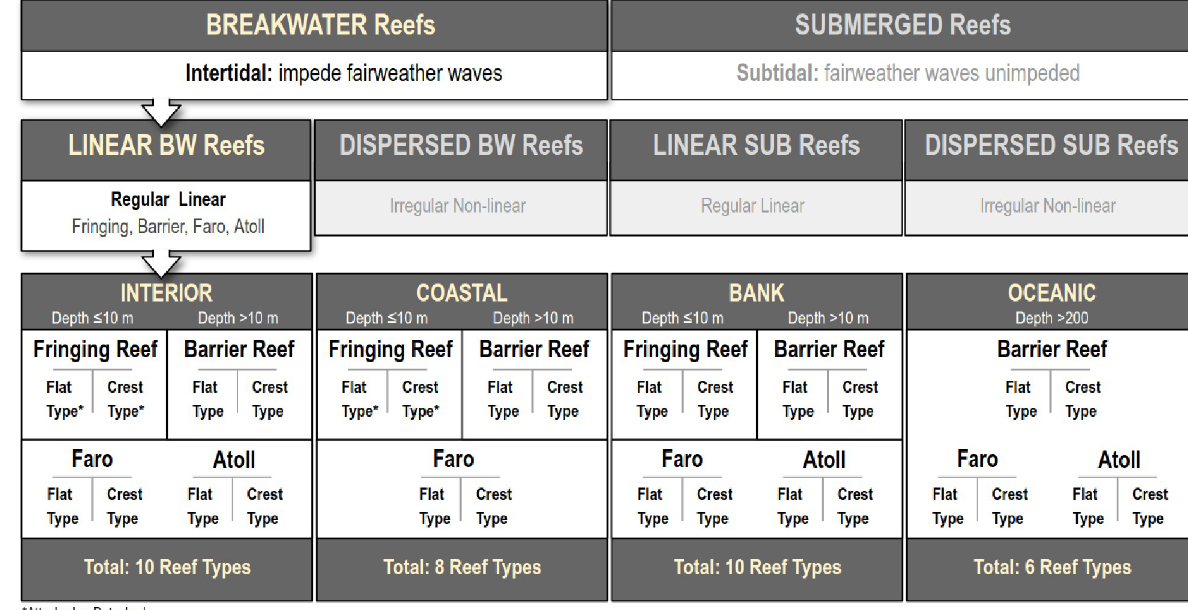
Fig 1. Standardised geomorphic classification of coral reefs showing the subcategories of linear breakwater reefs. There are 4 levels: The first is based on depth, with two categories, intertidal breakwater reefs, and subtidal submerged reefs. The second is based on form, with two categories, linear BW reefs and non-linear or dispersed BW reefs. The third, for linear BW reefs, is based on physiographic setting with four categories, Interior (protected Lagoons and Bays), Coastal (continental or insular shelves � 5 km wide), Bank (waters with a shelving seafloor shallower than 200 m, including shelves > 5 km wide) and Oceanic (waters lacking a shelving seafloor shallower than 200 m). The fourth is based on shallow geomorphology with two categories, Crest-type (sloping to subtidal depths on either side of the crest) and Flat-type (with an intertidal platform behind the crest). A final modification term for Fringing reefs is Attached to the coast (with no lagoon substrates, only back-reef) or Detached from it (with a lagoon). In total, this produces 32 possible categories of linear BW